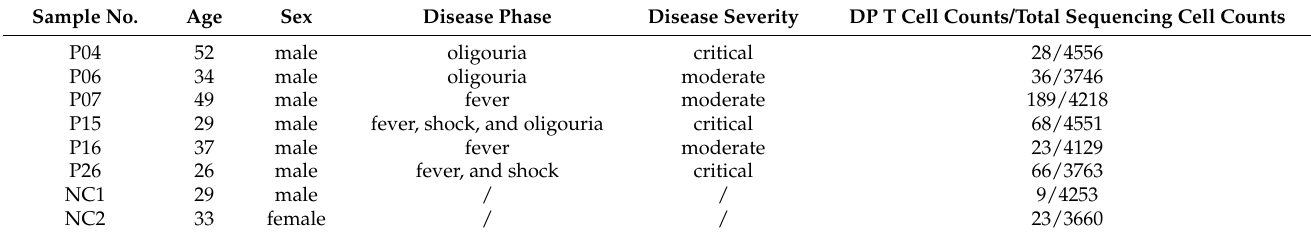
Table 2. Information of subjects enrolled in